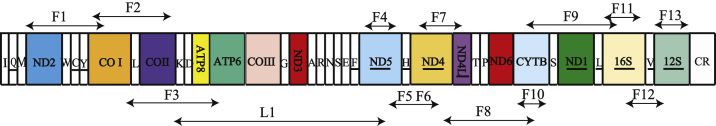
The primer strategy. Double-headed arrows indicate the location of the fragment amplified by PCR with each pair of primers. See Table 1 in the main text [1] for the primer DNA sequences associated with each fragment.